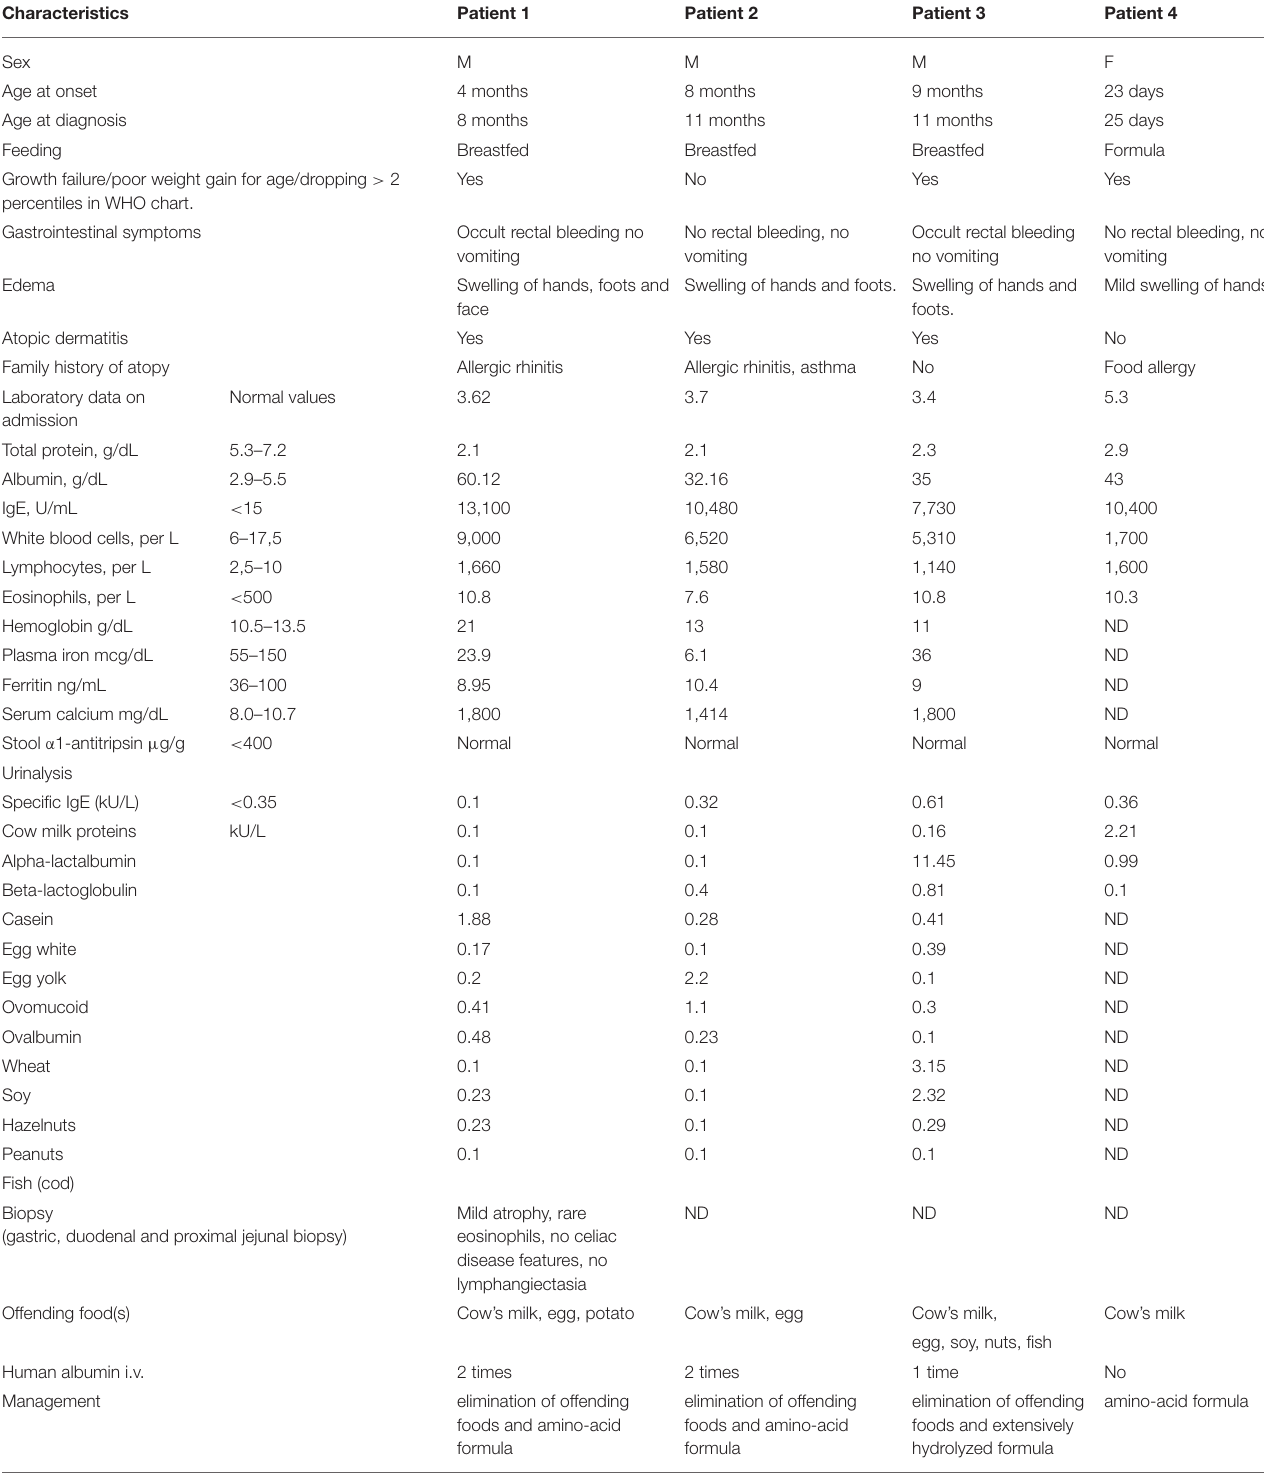
TABLE 1 | Clinical and laboratory characteristics of infants with food-protein induced protein-losing enteropathy (FPIPLE).